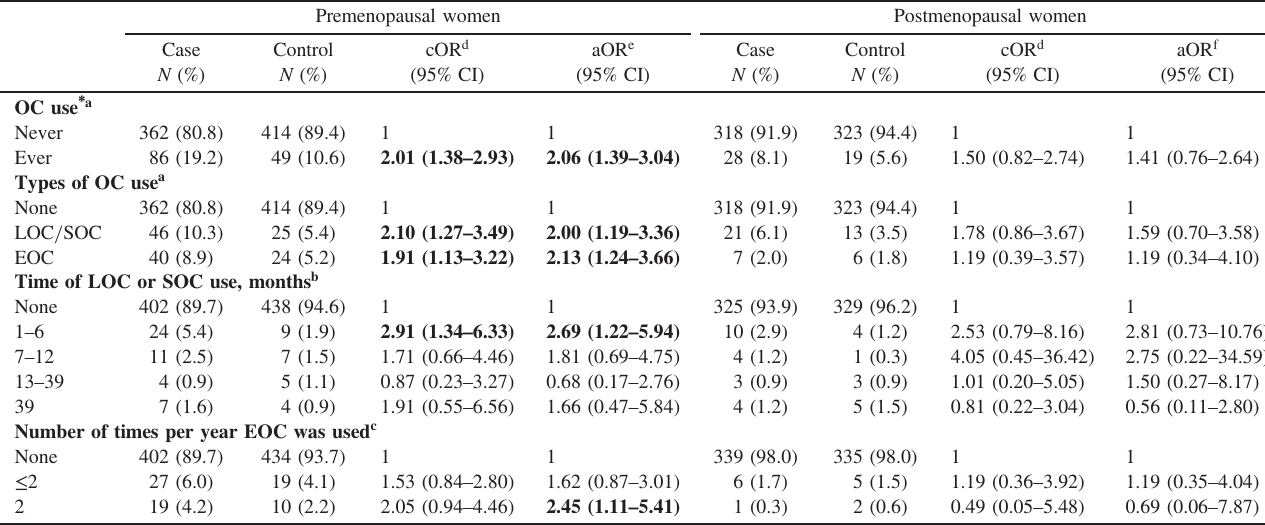
Table 2. Correlation between OC use and breast cancer